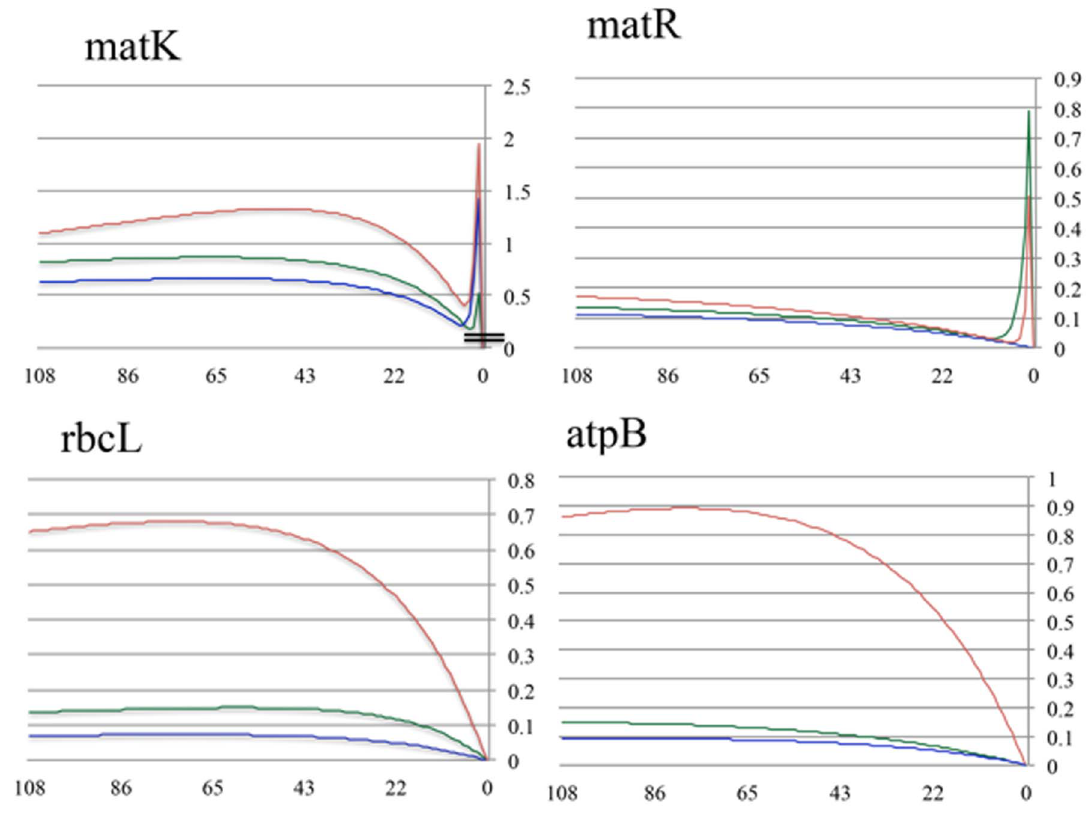
Figure 6. Informativeness profiles for codon positions measured in PhyDesign. Net informativeness profiles for 1 st (green), 2 nd (blue) and 3 rd (red) codon positions of matK , matR , rbcL , and atpB computed in PhyDesign. Note the informativeness values for matK codon positions starting at 0.5, highlighted by double lines on the y-axis. Both matK and matR exhibit spikes in their informativeness profiles at very recent times.